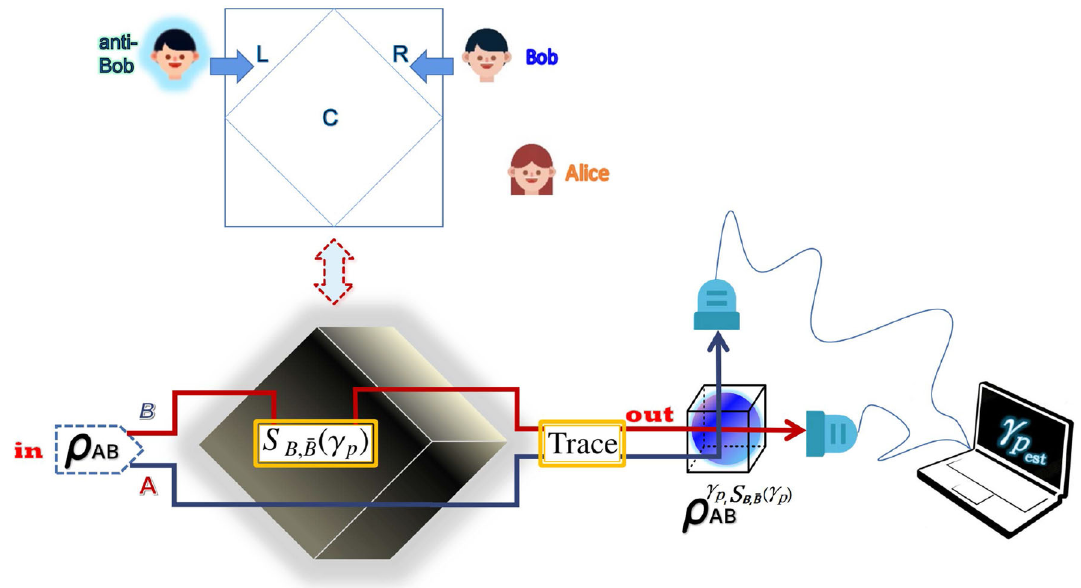
Fig. 1 Schematic diagram for the black-box optical quantum parameter estimation in the de Sitter space